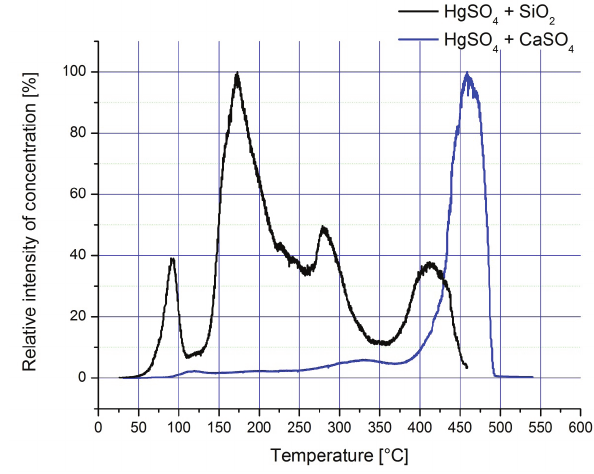
mixtures, obtained by 4